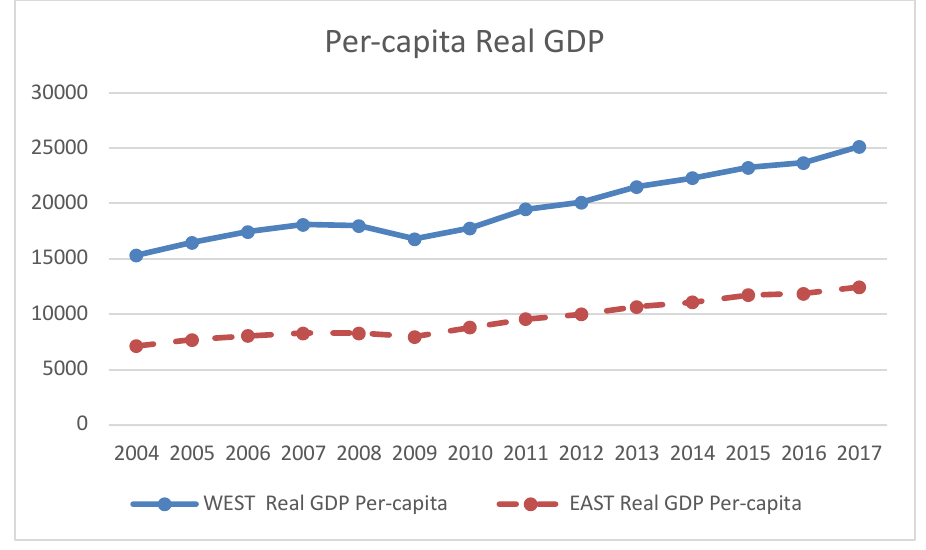
Figure 4: West-East Real GDP Per-capita